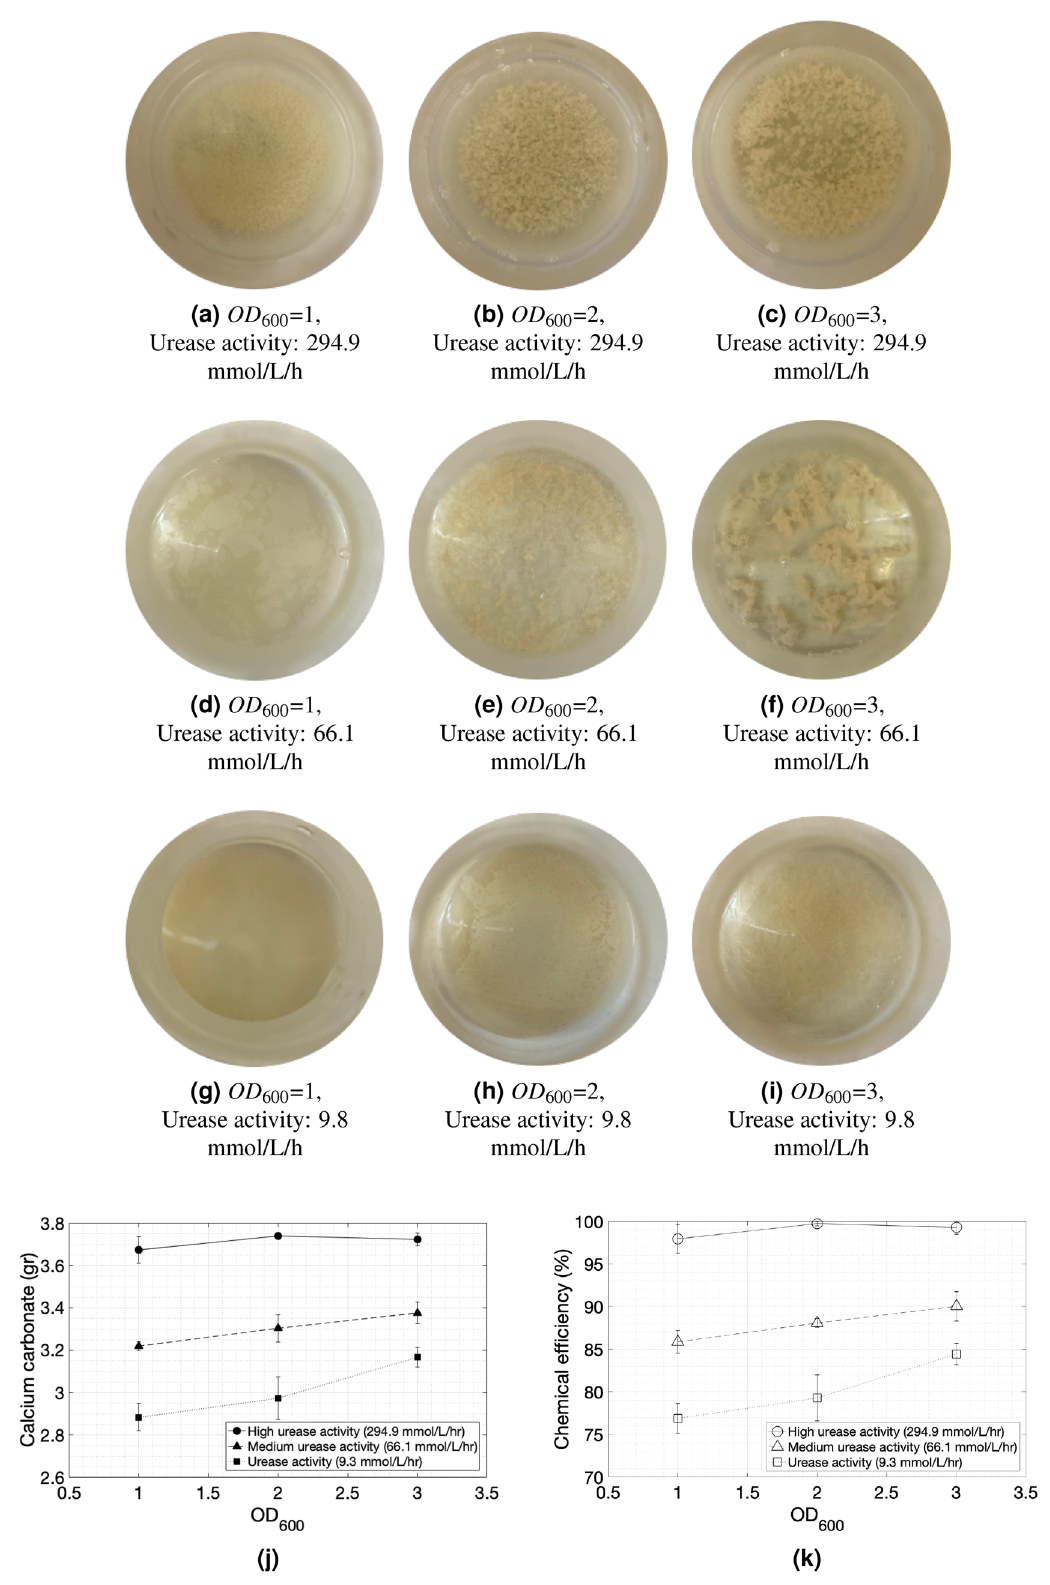
Figure 2. ( a – i ) Photographs of bacterial and cementation solution suspensions taken 24 h after the first cementation solution injection. From left to right, the initial optical density at OD 600 , increases from 1 to 2 and 3. From top to bottom, the urease activity decreases. ( j ) The precipitated calcium carbonate concentrations (gr) and ( j ) chemical efficiency (%) of the flask experiments across the various optical densities and urease activities. The carbonate concentrations are shown as solid shapes and the efficiencies as hollow shapes. The urease activity values reported in the figure are measured with the standard protocol 1